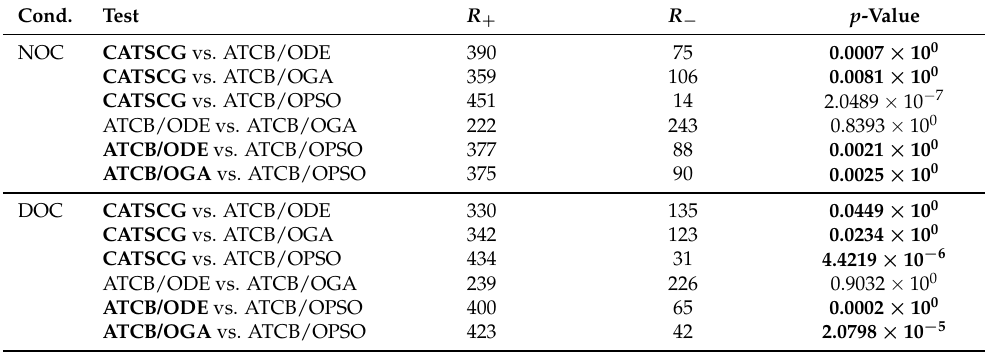
Table 5. Results of the pairwise Wilcoxon signed-rank test over the values of ISE for the adaptive controller tuning.